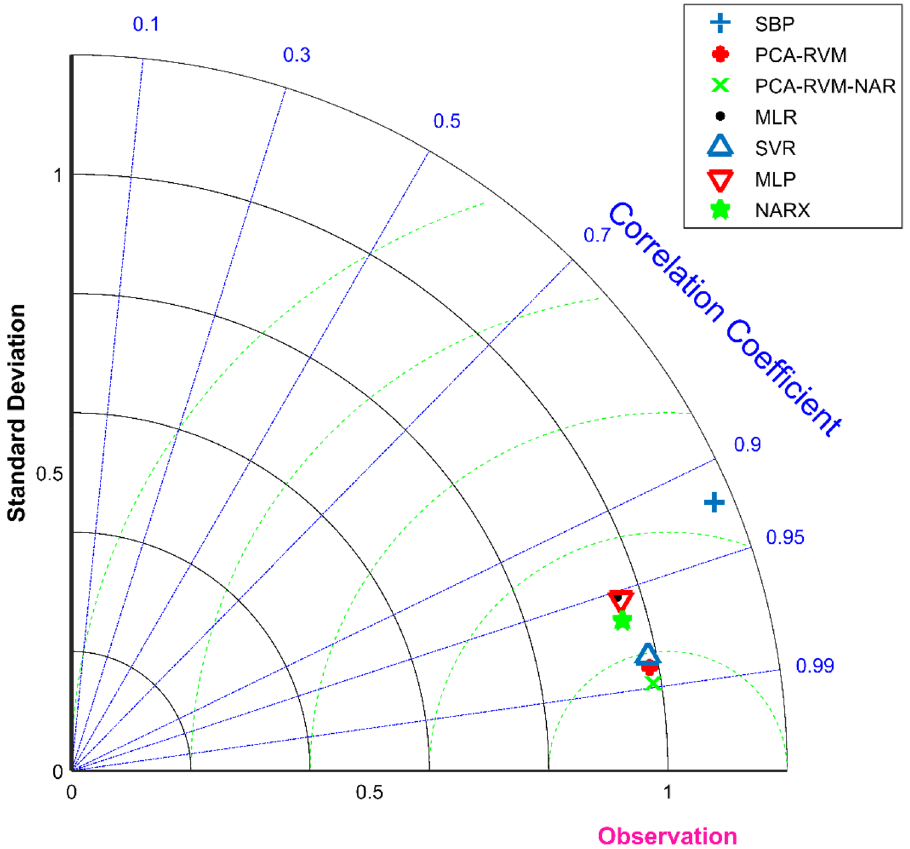
Figure 9. Taylor diagrams of the predicted PM 2.5 concentration for the six models and the measured value of the self-built point, where SBP represents the self-built